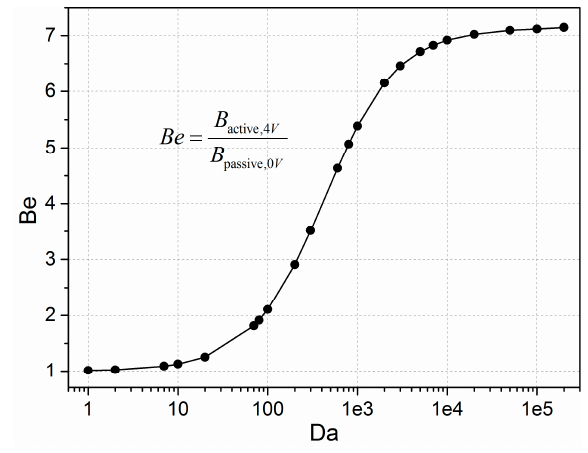
Figure 5. Plot for the binding enhancement factor Be in relation to increasing Damkohler number with the applied voltage of 4 V at 10 Hz.